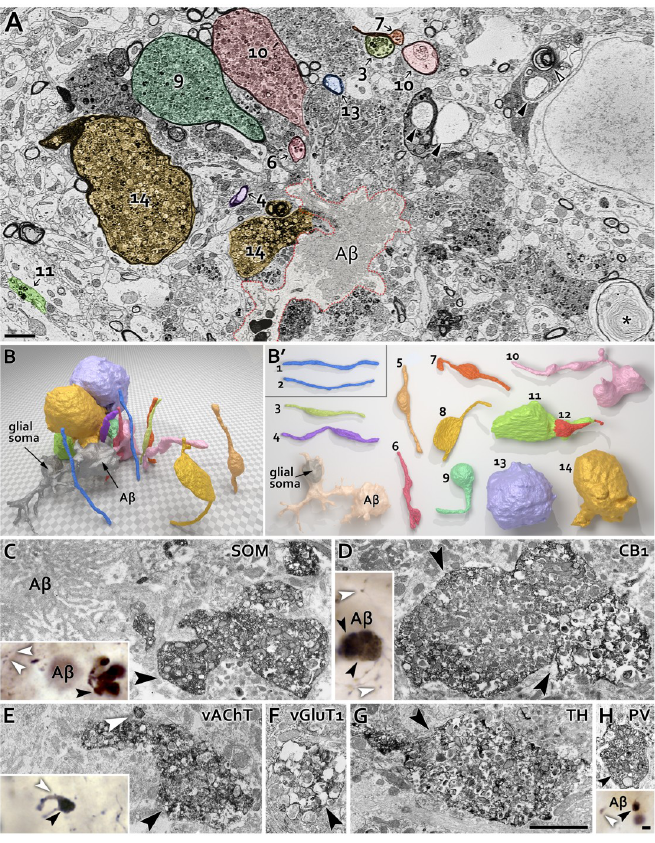
Fig 2. Diversely shaped dystrophic neurites and selective resilience of PV IN fibers in APP NL-F mice. A: Representative electron microscopic image shows an A β plaque at the border of strati radiatum and lacunosum- moleculare from CA1 of 24-month-old APP NL-F mouse. Several types of dystrophic neurites (DN) and A β - phagocyting microglia seem to be attracted to each other around the plaque center. Adjacent to DNs, there are different abnormal profiles e.g.: multilamellar bodies ( � ), vacuoles (black arrowheads) or split myelin sheaths (empty arrowhead). Amyloid deposits were detected in the extracellular space, and were also visible in microglia (dotted line). Scale bar: 2 μ m. B: Large volume 3D reconstruction of a group of differentially affected axons (that regardless of their myelination were strongly dystrophic) and A β containing microglia (indicated on panel A). B’: Different stages of axonal degeneration (3–14, also on panel A) were visible around the plaque center (A, B). Some of them seemed healthy (1, 2), while other myelinated axons at least partially lost their myelin sheaths, mainly on the side that is facing to the amyloid-accumulation (10, 14). Also see S1 Video. C-H: Comparison of the sizes of DNs and healthy neurites of different types of neurons (DAB immunolabeling, dark precipitation) in 18-month-old APP NL-F mice. Correlated light and electron micrographs show dystrophic terminals (black arrowheads) positive for somatostatin (SOM, C), cannabinoid type 1 receptor (CB 1 , D), vesicular acetylcholine transporter (vAChT, E), vesicular glutamate transporter 1 (vGluT1, F), tyrosine hydroxylase (TH, G) or parvalbumin (PV, H). White arrowheads indicate typical healthy- looking boutons. Light and electron micrographs that are on the same scale (respectively) demonstrate that most DNs are hundreds of times larger than healthy counterparts, however, the enlargement of PV-positive DNs were much less pronounced, while they were detected only very rarely. All scale bars: 2 μ